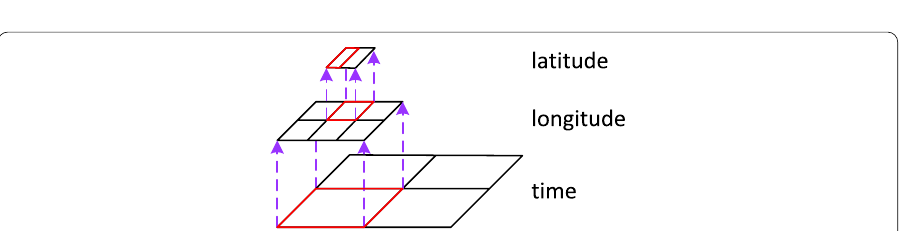
Fig. 4 Example of multi-level